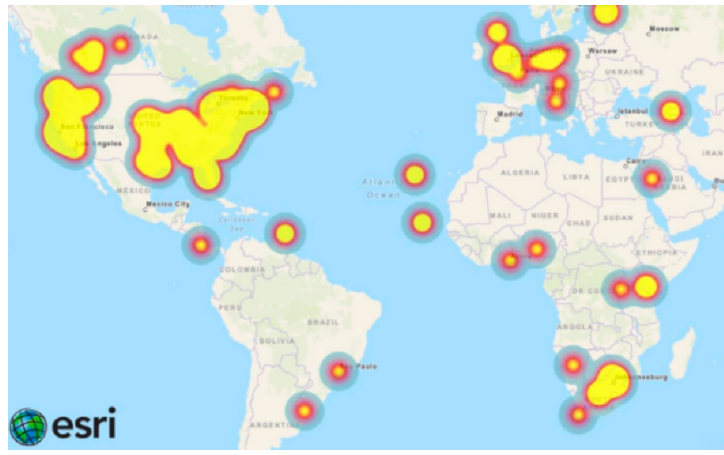
Figure 1. Heat map highlighting locations where power outages occurred across the globe [15].